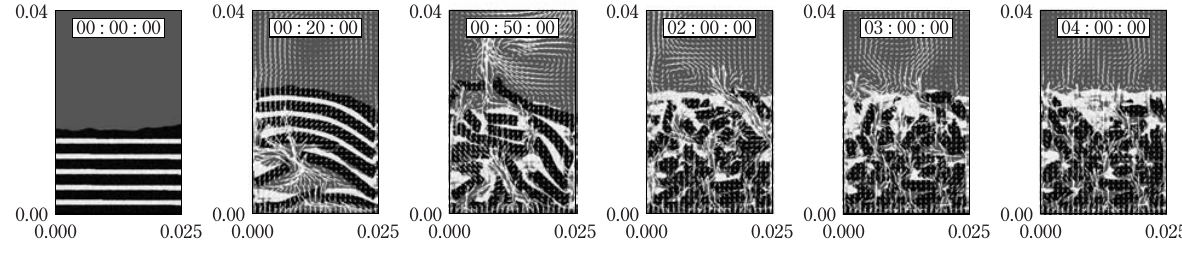
Fig. 3 The gas-solid flow patterns with an initial five layers of 12,500 cohesionless (white) particles placed alternatively in the bed of 32,500 cohesive (black) particles at u/u mf (cid:1) 4.8. The ratio of the maximum cohesive force at z min to particle weight